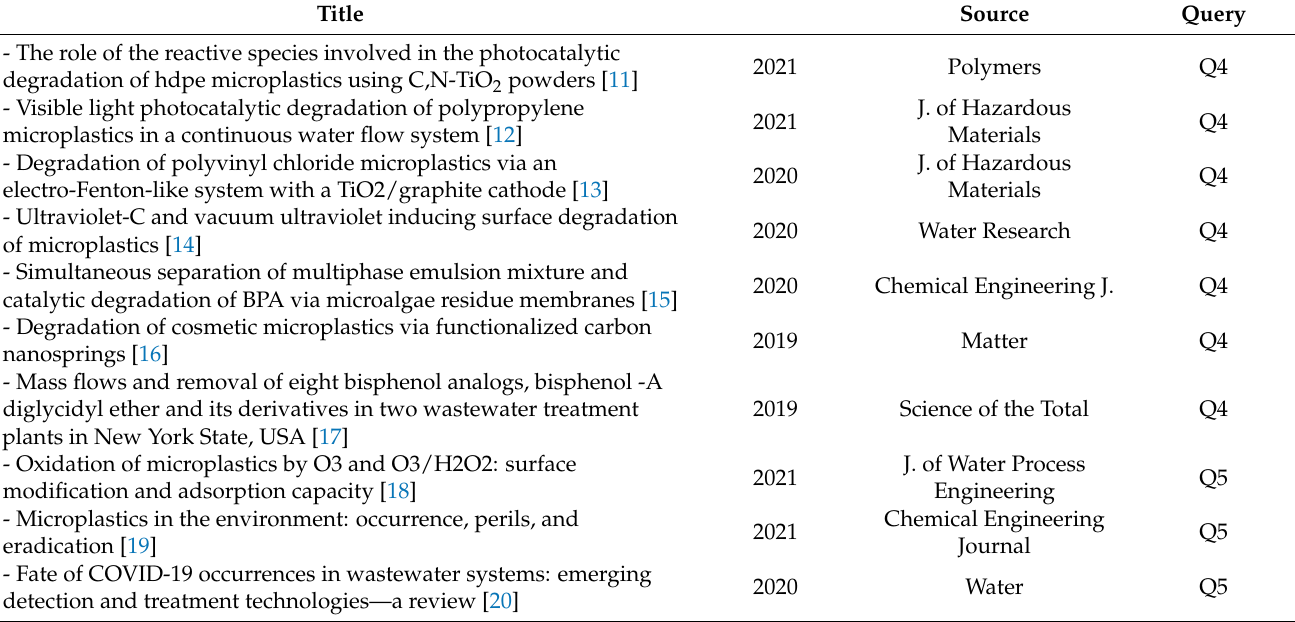
Table 1. List of the articles derived from the queries Q4 and